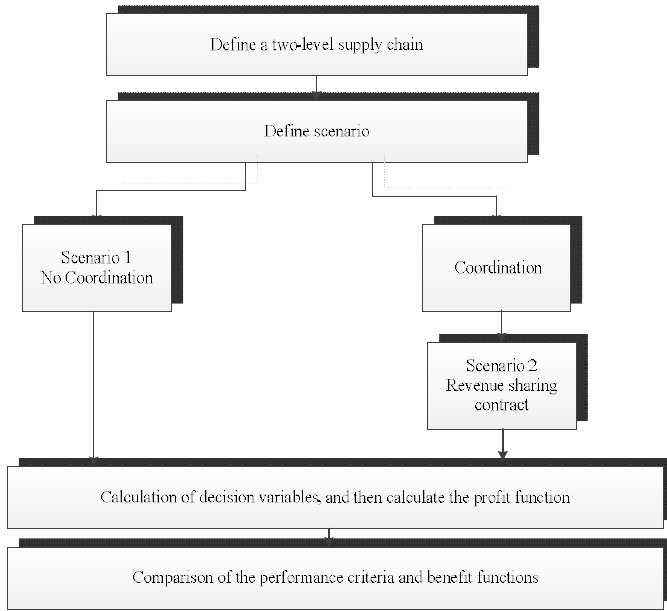
Fig. 1. Procedure for